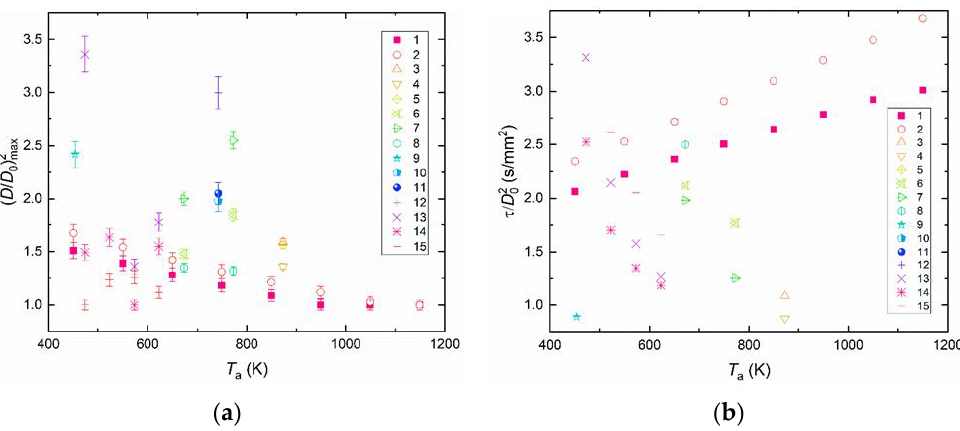
Figure 9. Generalized experimental data on maximum values of ( D / D 0 ) 2 ( a ) and τ/(D 0 ) 2 ( b ) vs. gas temperature for different fuel compositions in the course of breakup: 1 — C50W49D1 (current